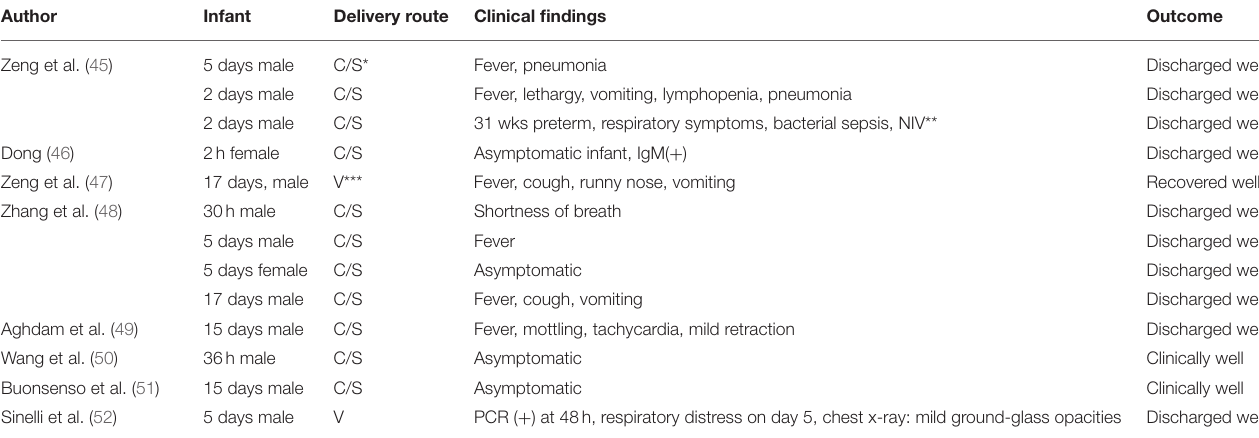
TABLE 1 | Reports on infants with SARS-CoV-2